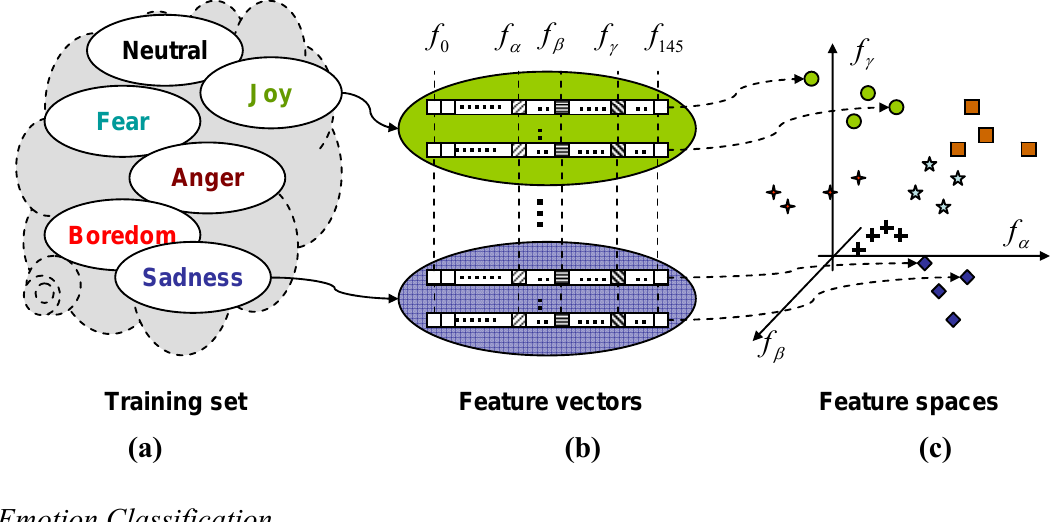
Figure 4. Training set with labeled emotional sentences (a), 146-element feature vectors derived for each sentence (b) and sample three-dimensional feature space, with training-set samples from all of the categories